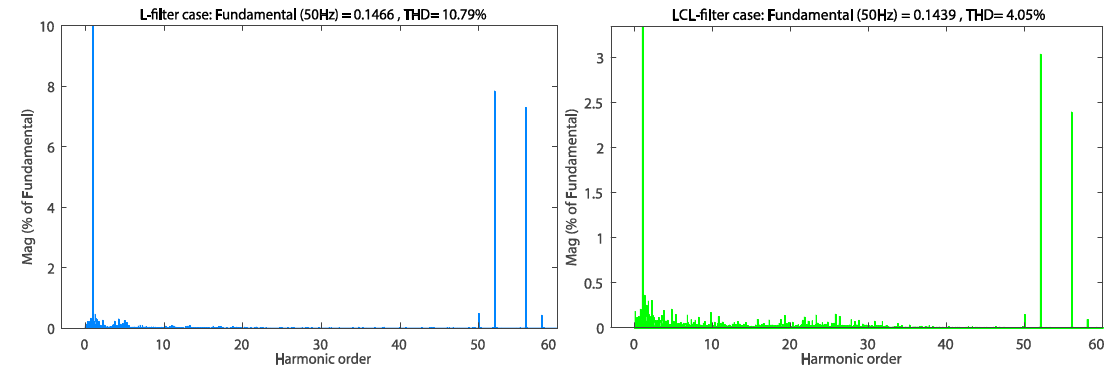
Figure 12. Harmonics spectrum of the AC grid currents.